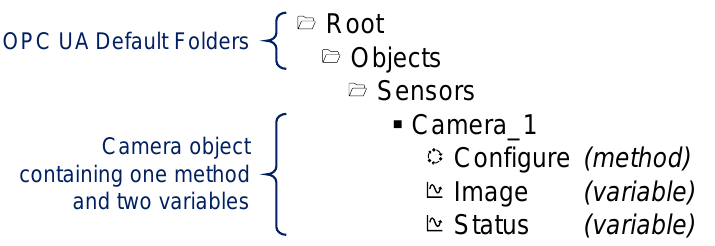
Figure 5. Exemplary information model for a sensor